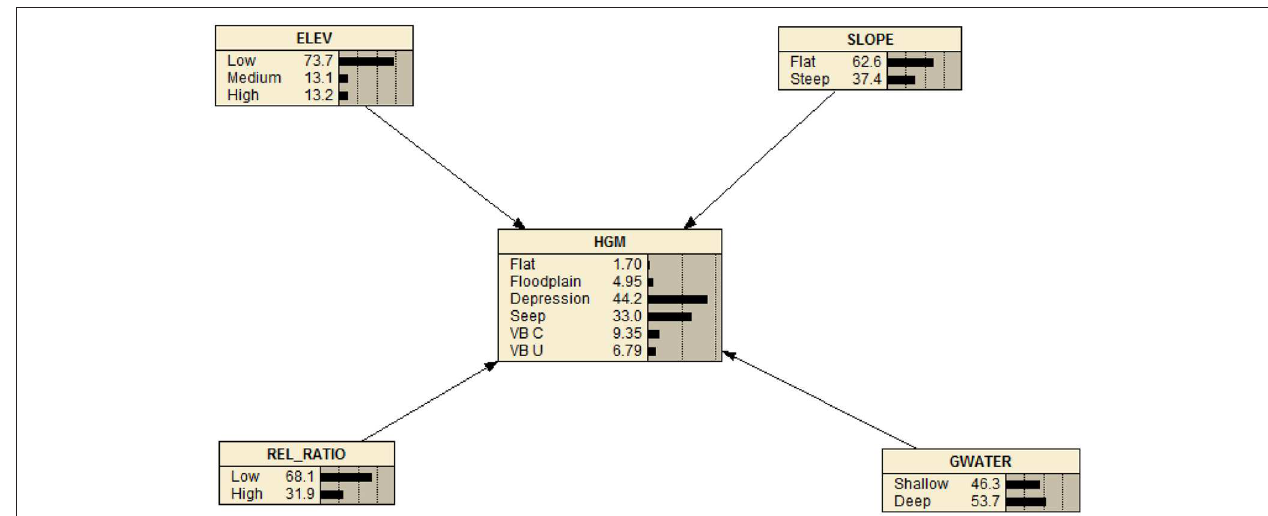
FIGURE 8 | Bayesian network model for predicting wetland HGM type based on node states for elevation, slope, groundwater depth, and catchment relief ratio.